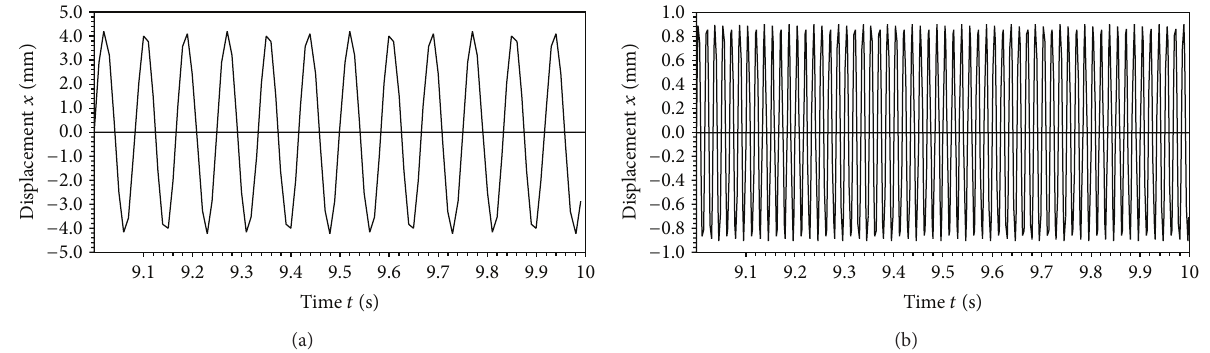
Figure 6: The displacement similarity of the vibrating screen. (a) The displacement of the prototype screen. (b) The displacement of the model screen.